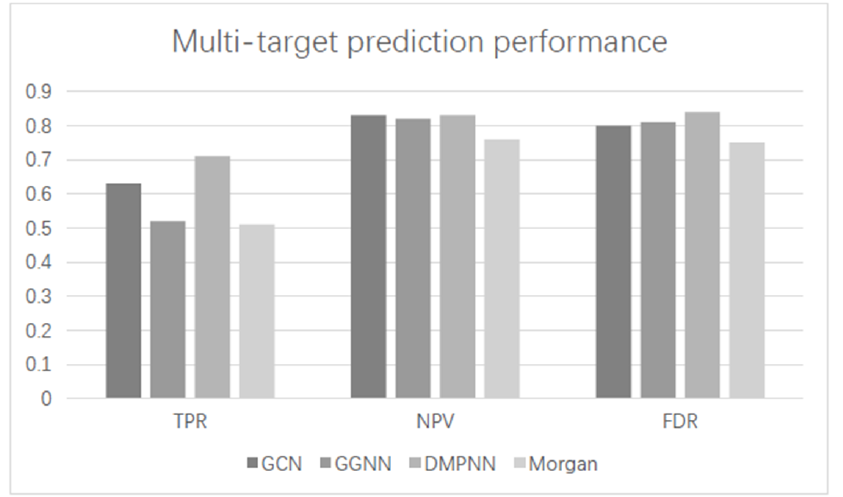
Figure 5. Multi-target Performance comparison with different models. The supervised learning algorithm was XGBoost. TPR, NPV, and FDR for all compounds on the combination classifier. Hence, the DMPNN+XGBoost multi-target classification model was employed as our DNA methylation and histone modification multi-target predicting